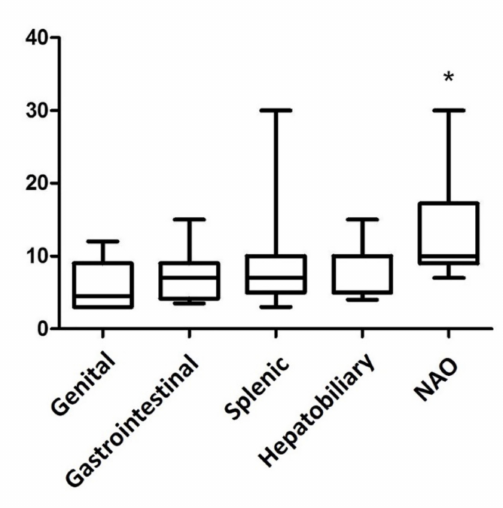
Figure 1. Box plot of the abdominal mass size in various organ sites. The masses not associated with any organs (NAO) are significantly larger than the lesions in the genital tract and in the spleen ( p = 0.0084 Kruskal–Wallis test and Dunn’s multiple comparison test). * p -value ≤ 0.05 considered as